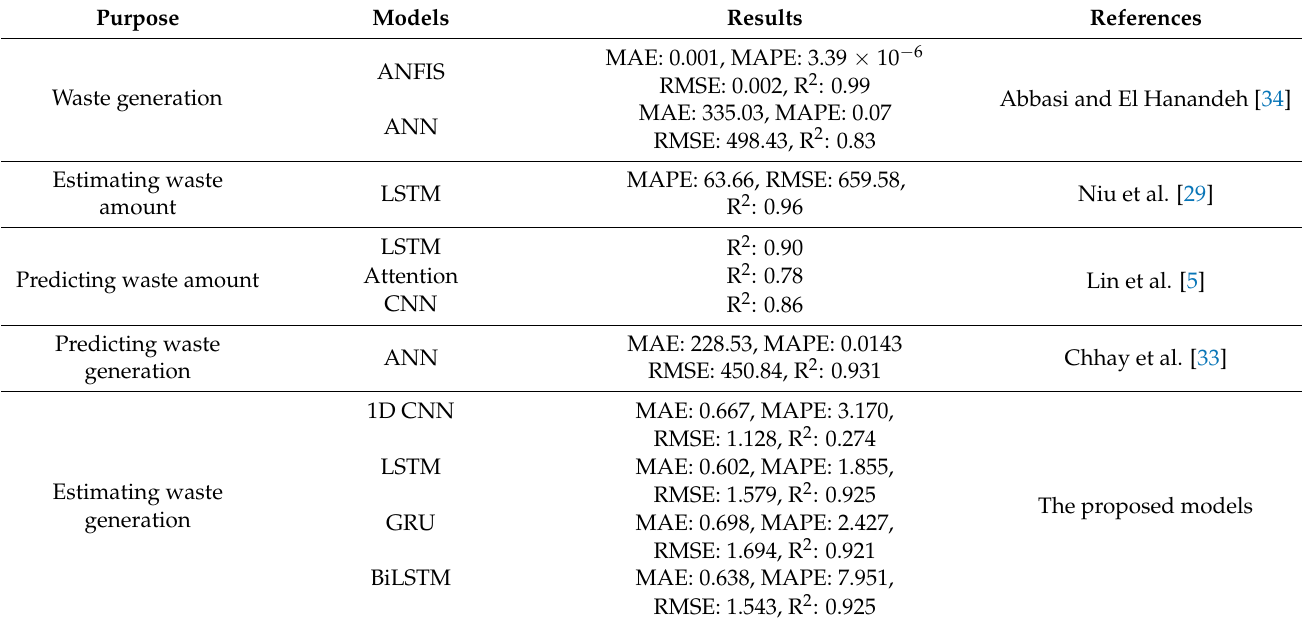
Table 5. A comparison between previous work and the models proposed in this